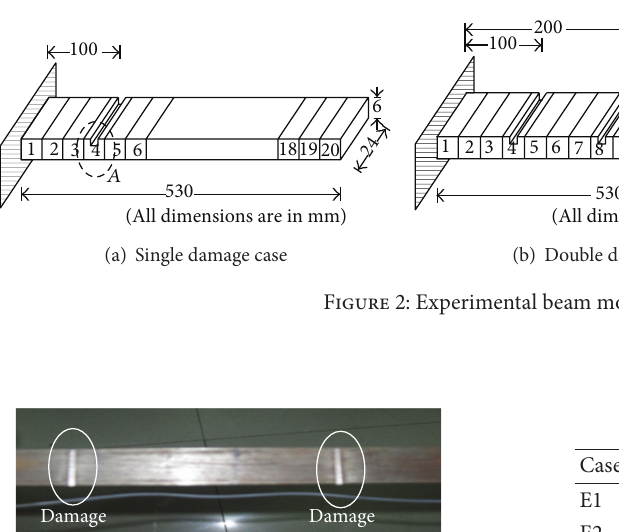
Figure 3: Damages in experimental beam.